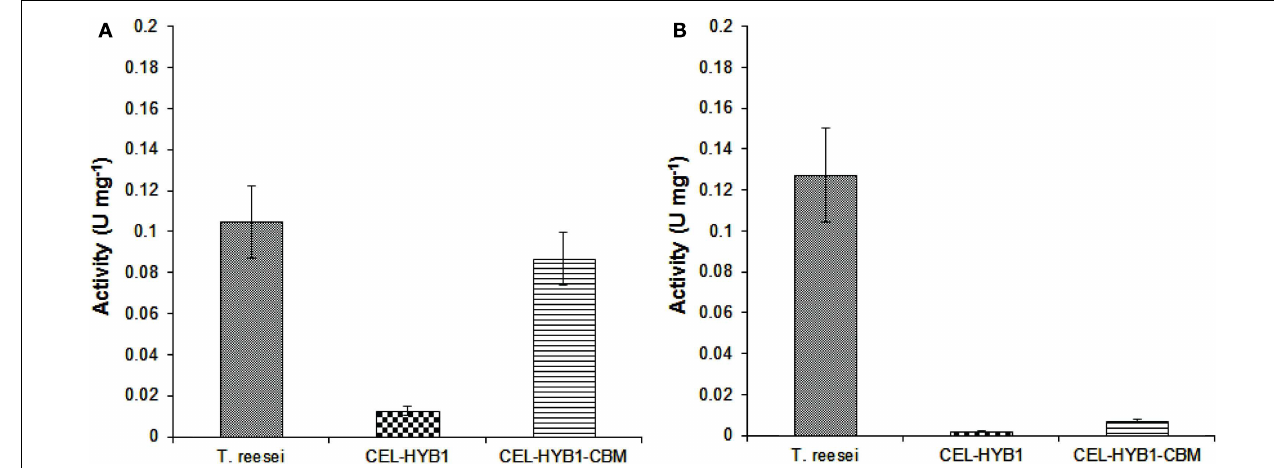
FIGURE 4 | Endo-and exo-glucanase activity of CEL-HYB1 with and without the CBM. The endo- β -1,4-glucanase (A) and exo- β -1,4-glucanase activity (B) of CEL-HYB1, CEL-HYB1-CBM, and the T. reesei cellulase enzyme cocktail (Umg − 1 ± SD) were compared. Measurements shown in (A) were